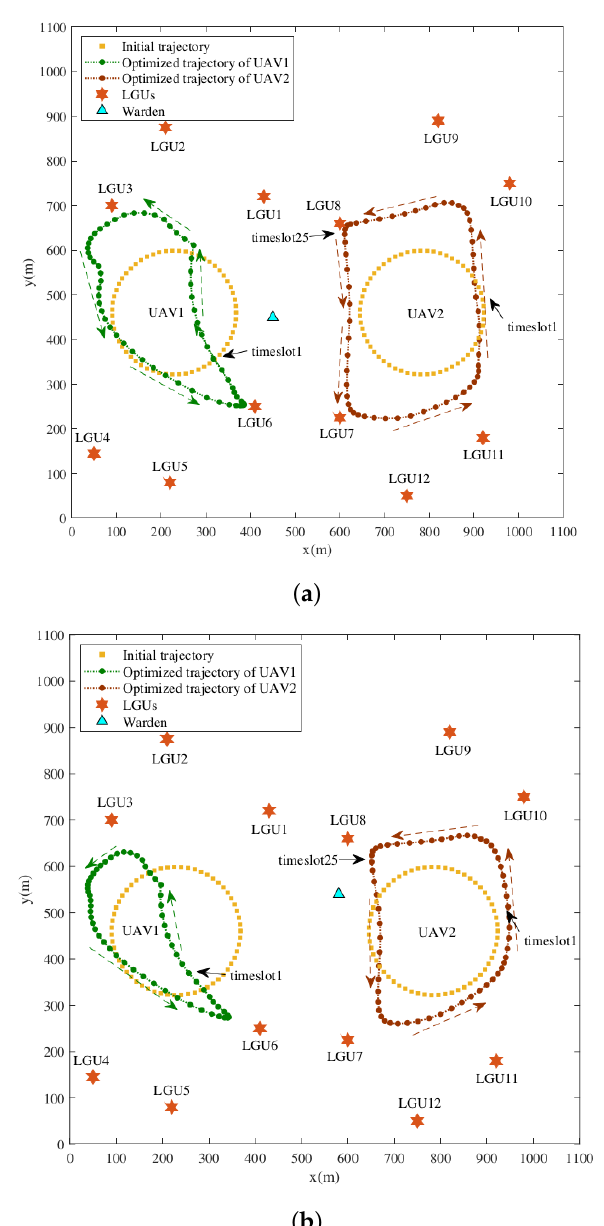
Figure 2. Optimized multi-UAV trajectory for different warden positions. ( a ) The warden is located at [ 450,450 ] T . ( b ) The warden is located at [ 580,540 ] T